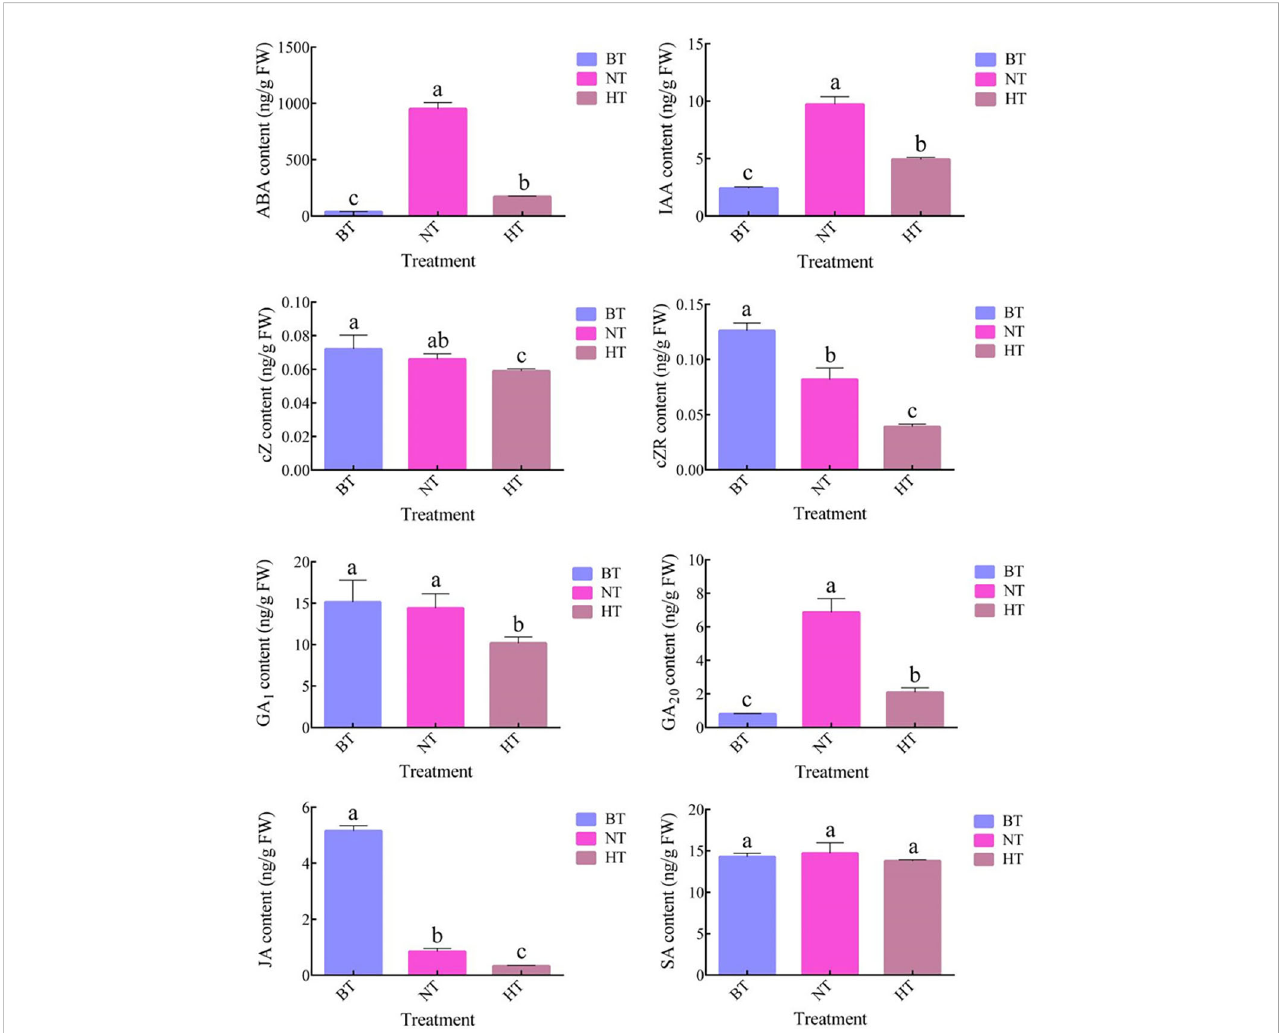
FIGURE 4 The contents of plant hormones in sweet cherry peel under different treatments. The values represent the means ± SDs, n = 3. The different letters indicate signi fi cant differences among different treatments according to Duncan ’ s test (p <